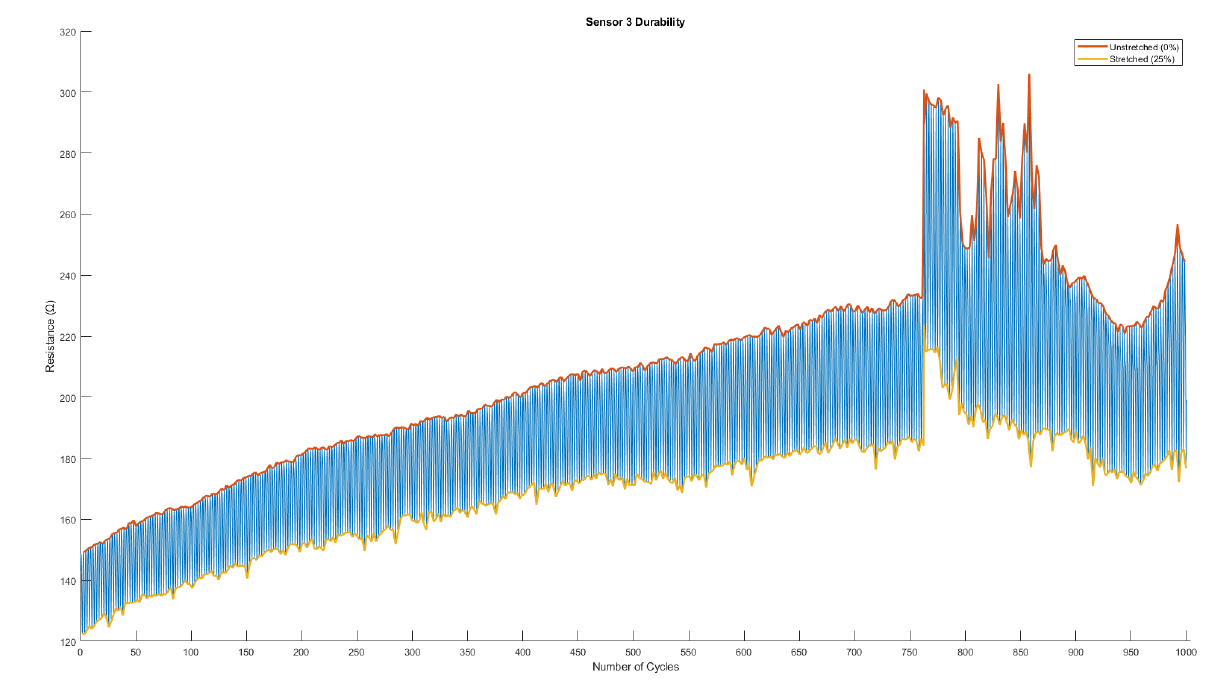
Figure A3. Durability Result (Sensor-3).